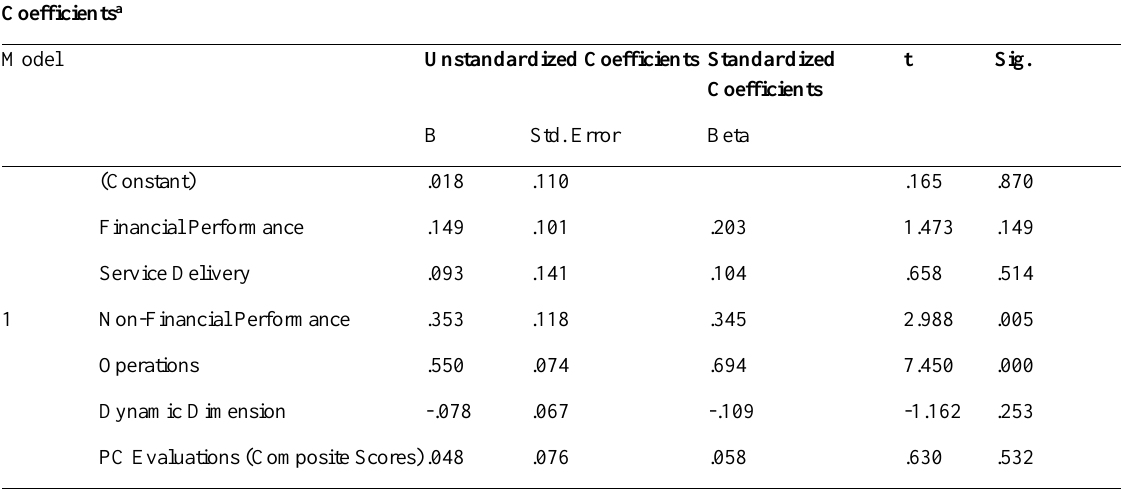
Table 11: Coefficients for Extent of Utilization of Performance Contracting as a Tool for Strategy